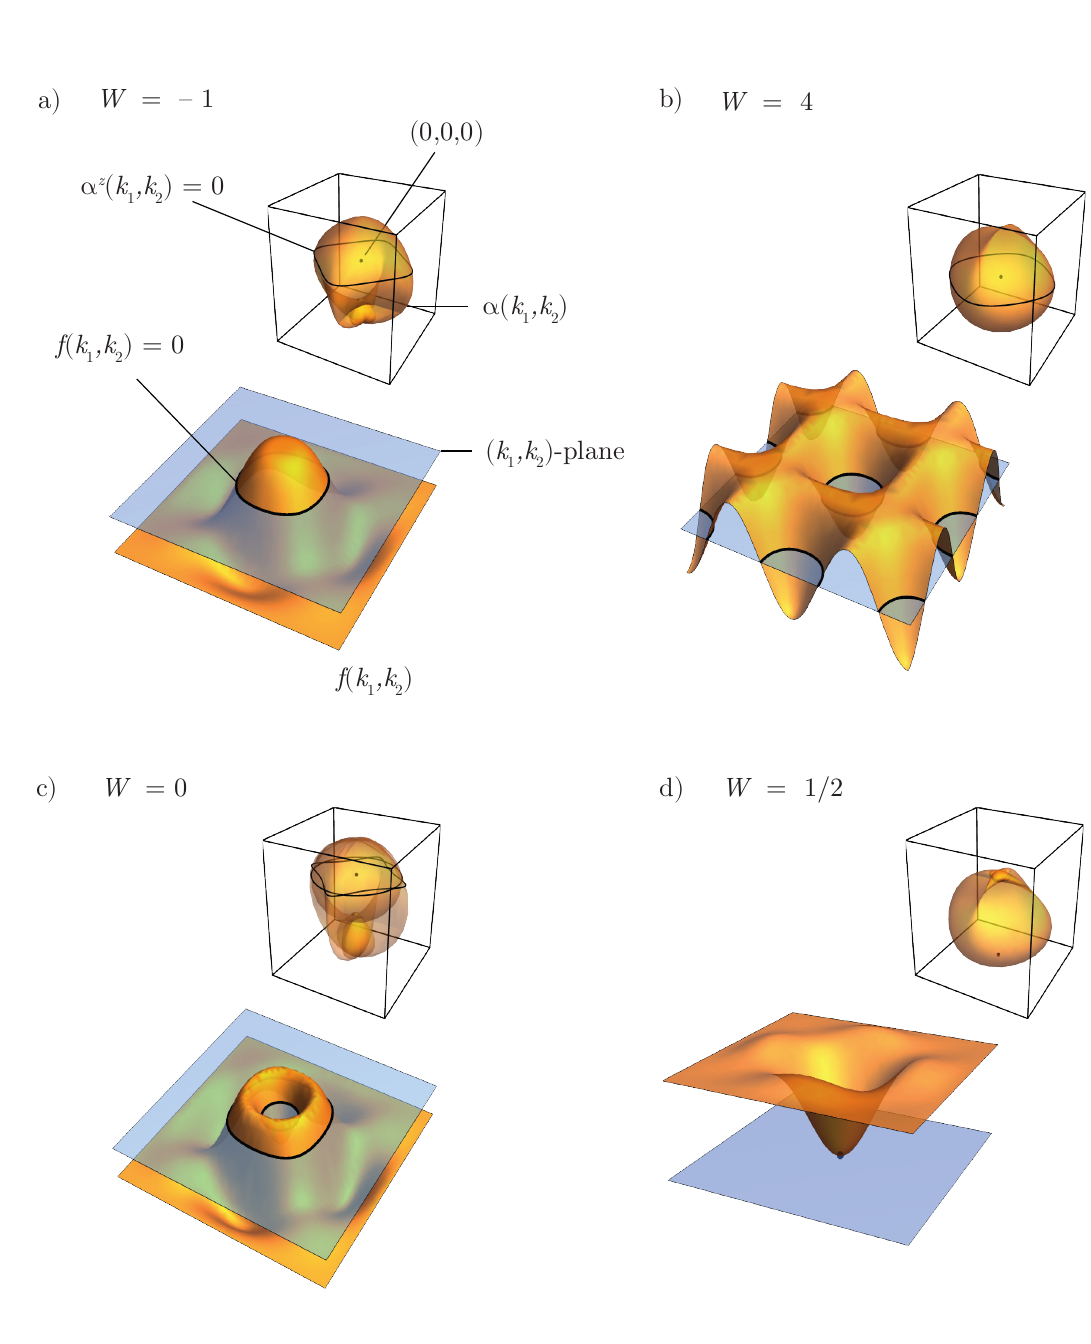
Figure 2: Smooth periodic functions f ( k 1 , k 2 ) and their corresponding closed surface α ( k 1 , k 2 ) and winding number W . Note that the winding number can be positive or negative. Functions with isolated nodes such as d) are related to phase